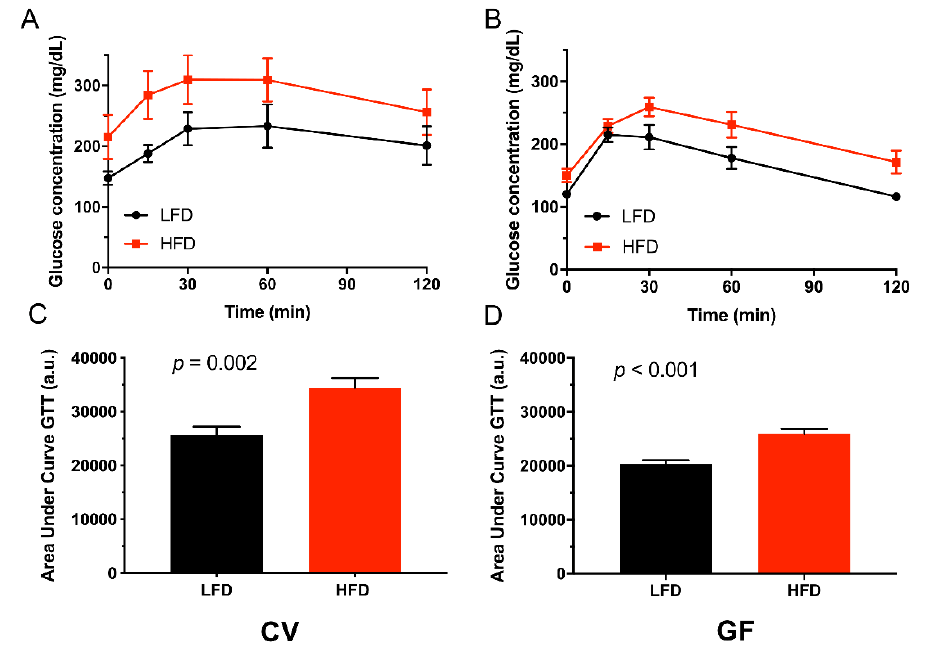
Figure 4. The HFD impairs glucose clearance. Results of the GTT (panels A,B ) in CV ( n = 10) and GF ( n = 11) mice on the LFD control or the HFD. The values for individual mice are shown as dots and horizontal lines indicate the standard error of the mean ( ± SEM). The calculated area under the curve is shown in panels C and D , for CV and GF mice, respectively. Statistical analysis via two-sided Student’s t-test, statistical significance was set at p ≤ 0.05. Abbreviations: CV, conventional; GF, germ-free; GTT, glucose tolerance test; HFD, high fat diet; LFD, low fat diet.